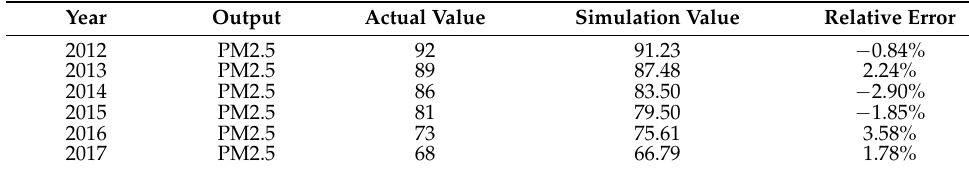
Table 1. Results of authenticity fitting.